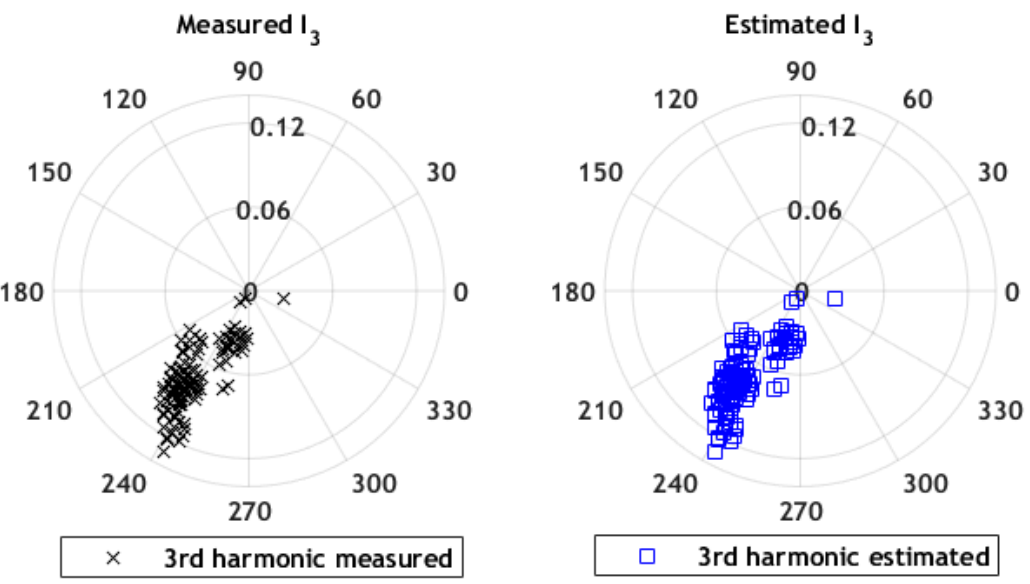
Figure 4. Measured harmonic currents’ RMS levels (with respect to RMS of fundamental harmonic current components) of 120 lamp combinations.